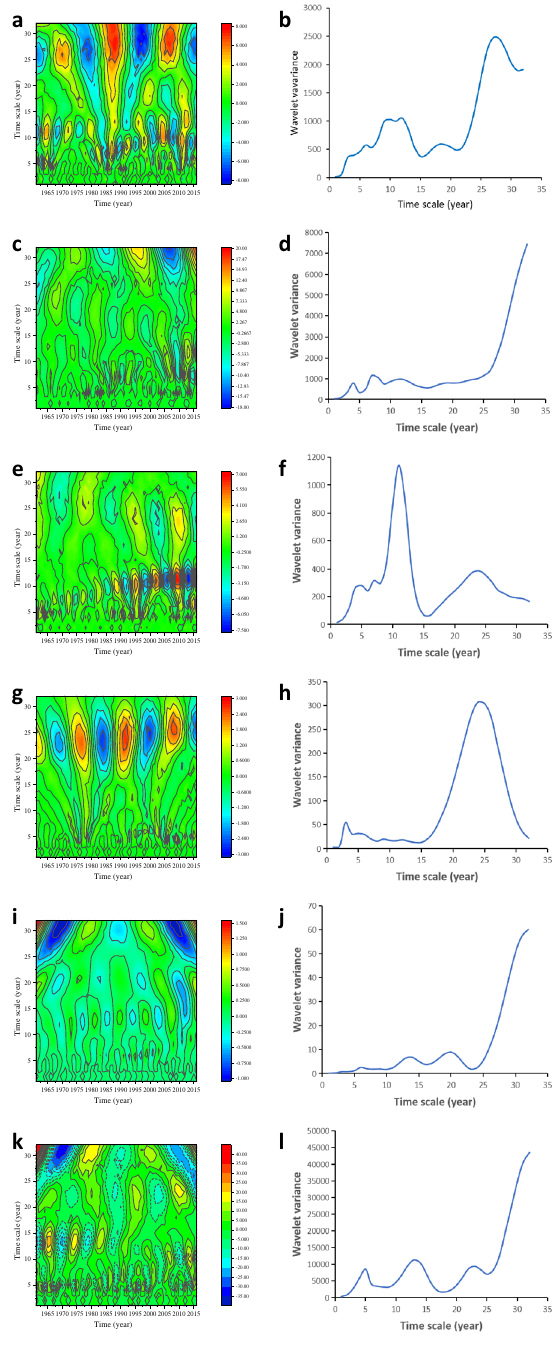
Figure 4. Real contour map of wavelet coefficients and wavelet variance of seasonal precipitation ( a ), ( b ) spring precipitation ( c ), ( d ) summer precipitation ( e ), ( f ) autumn precipitation ( g ),( h ) winter precipitation ( i ),( j ) annual average temperature ( k ),( l ) area